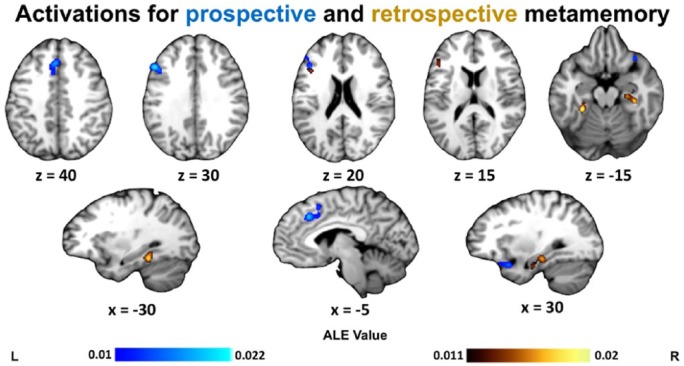
ALE results for contrasts of prospective metamemory (blue) and of
retrospective metamemory (yellow). Clusters are displayed in MNI
standard space. Multiple-comparisons correction was applied at the
cluster level at a family-wise error-corrected threshold of
p < .05, 5000 permutations, and a
cluster-defining threshold of p < .001
uncorrected.